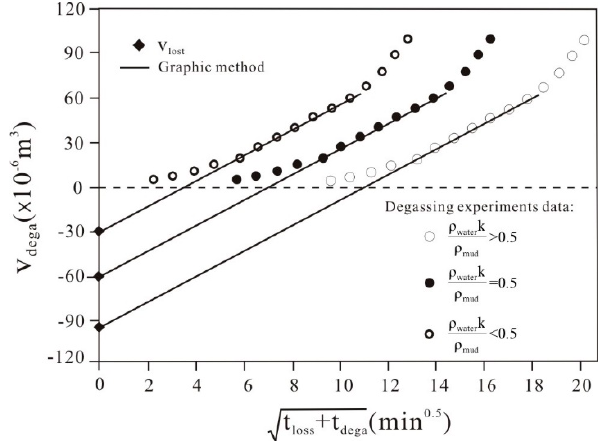
Figure 5. The calculation of lost gas volume in three types of gas loss time.